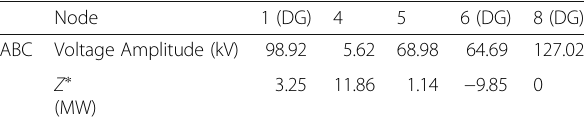
Table 1 Voltage amplitude and objection function values of key nodes (Fault 1)